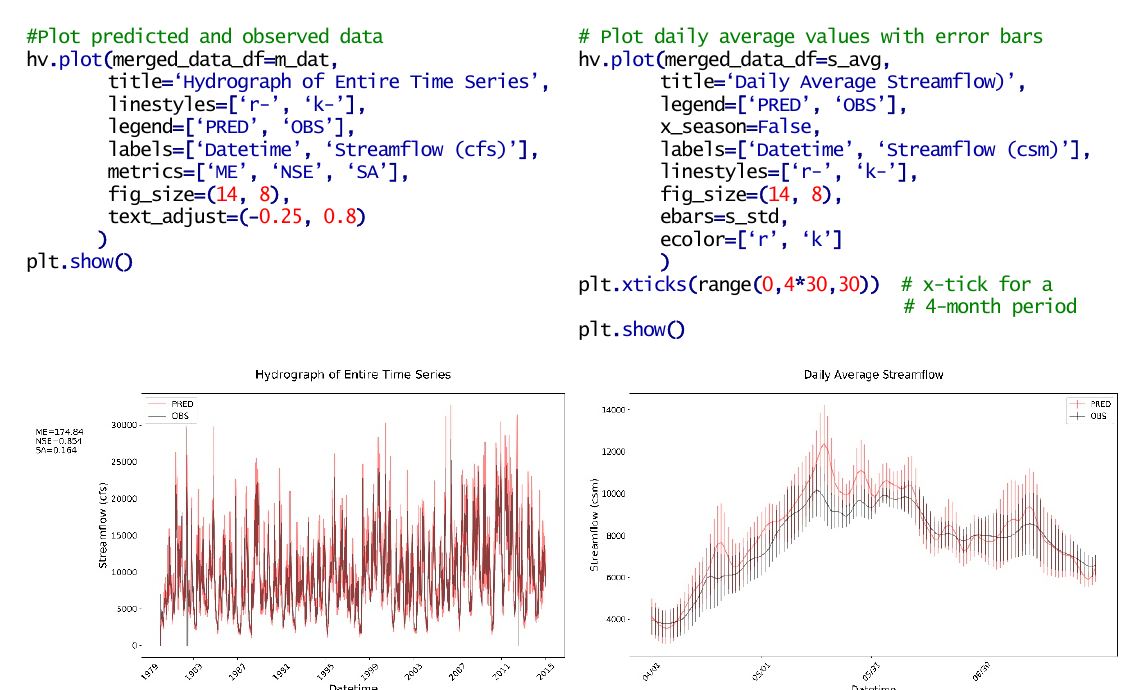
Figure 3. Presents an example of hydrostat.visual code and plots that show the simulated and observed data ( left panel ) and daily averages over a season from April to July ( right panel ). The plots use the data from Figure 2, the m_dat data frame for the entire record, and the s_avg and s_std data frames for the daily averages with error bars over a shorter season. Note that in the right panel, in addition to the plot, the results from three different error metrics are included.